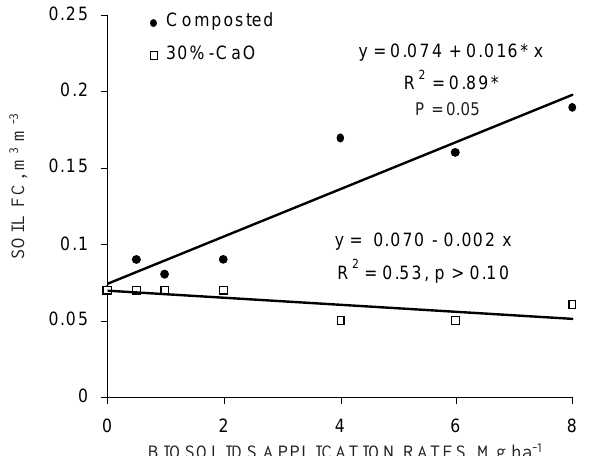
Figure 2. Regression of NO 3- -N expected to leach (N ) on NO 3- -N available for leaching (N L amended Spodosol and Oxisol considering 20 cm topsoil.